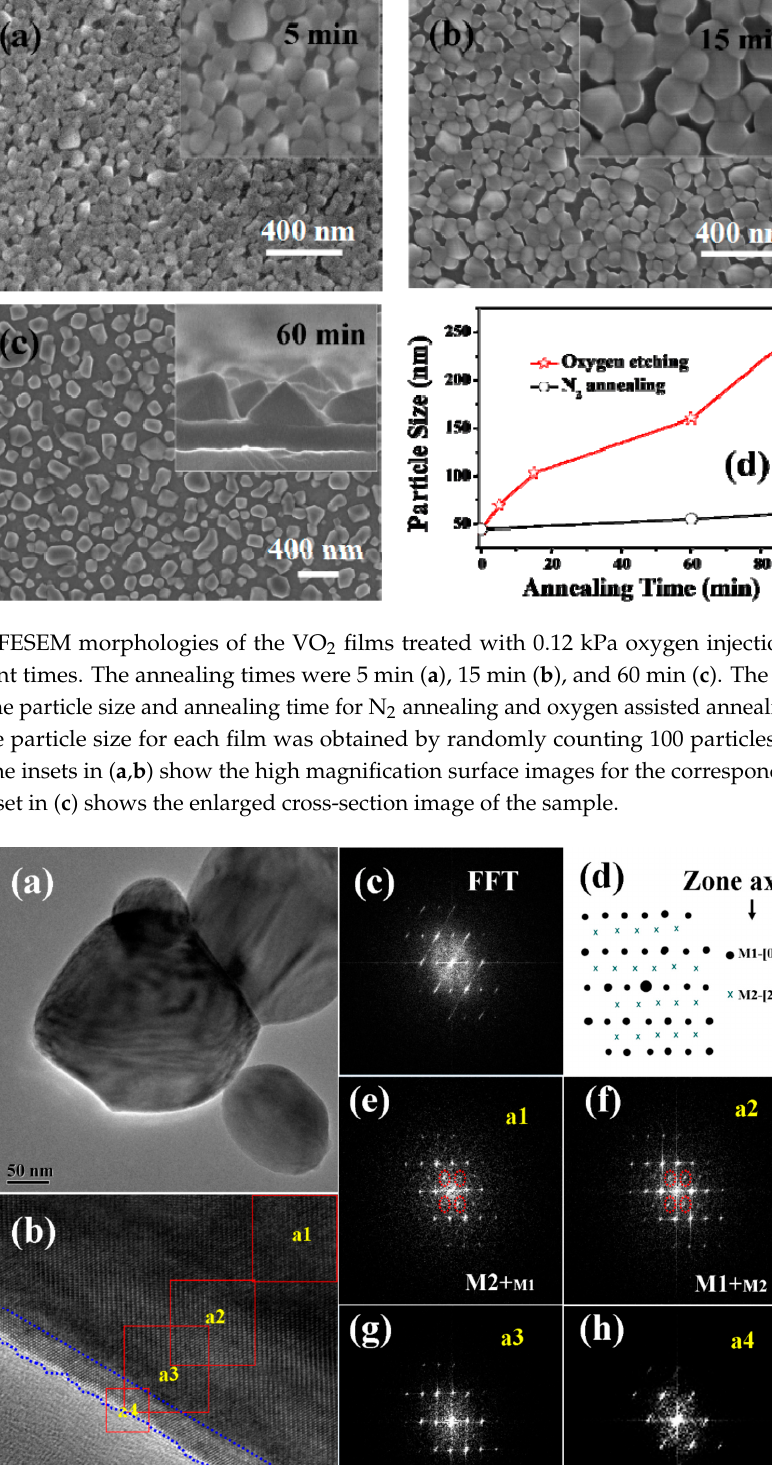
stronger and stronger. These results agreed well with the XRD and Raman results, further confirming the formation of composite phases in the pyramidal films.